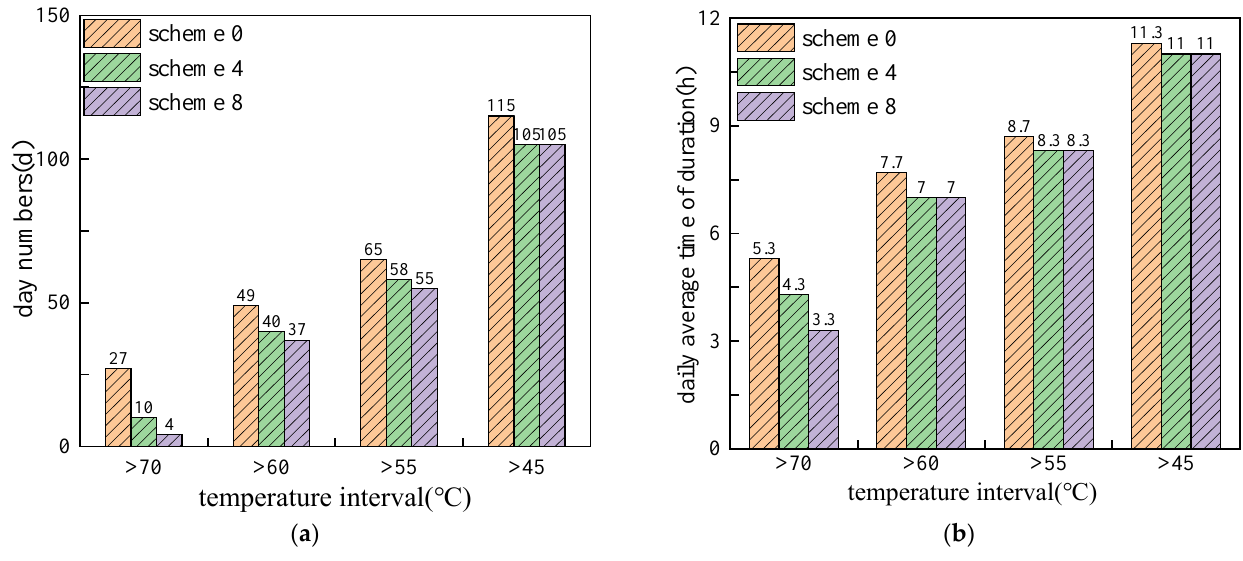
Figure 13. Duration times of daily maximum pavement temperature in different temperature ranges with 20% PCM mixing ratio: ( a ) number of days; ( b ) daily average duration in hours.